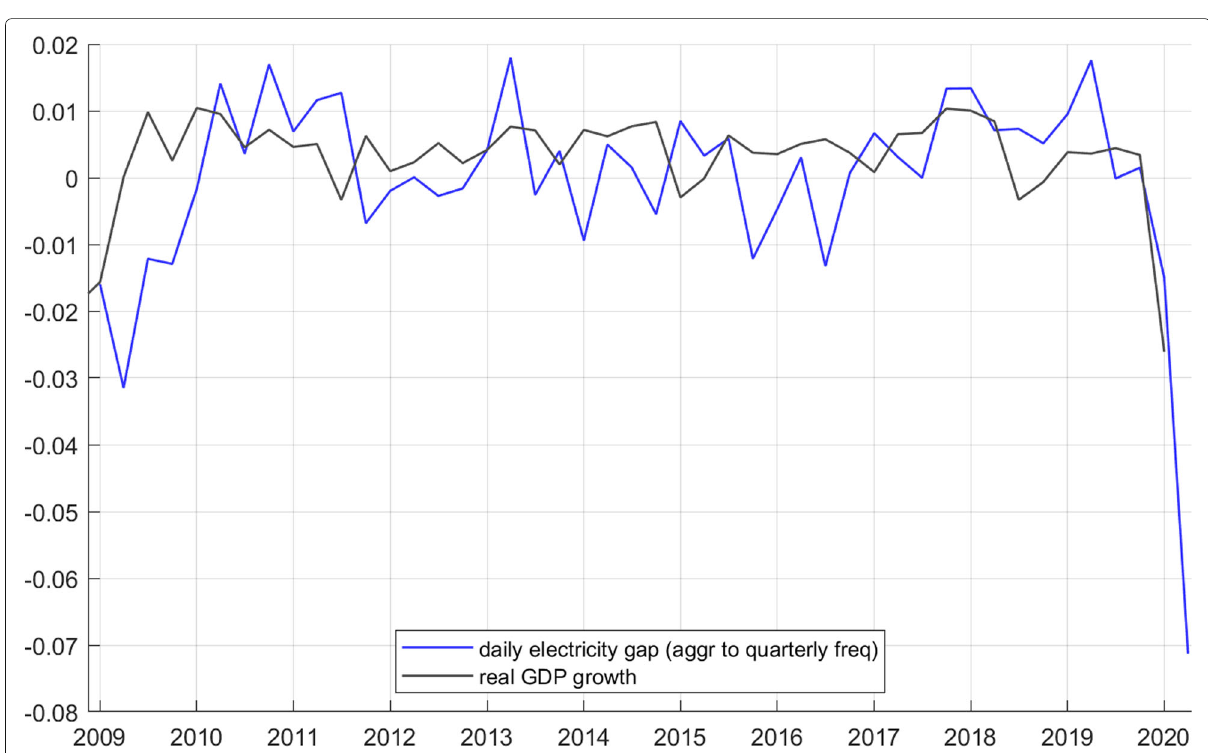
Fig. 8 Real GDP quarterly growth rates in black, and daily electricity gap in red, aggregated to quarterly